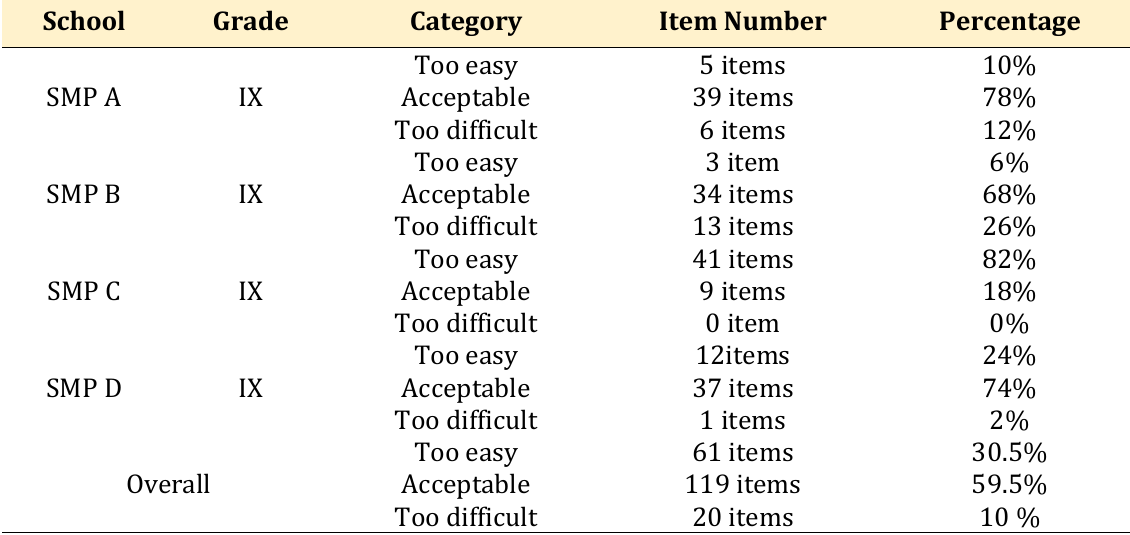
Table 4. Discrimination Index of the